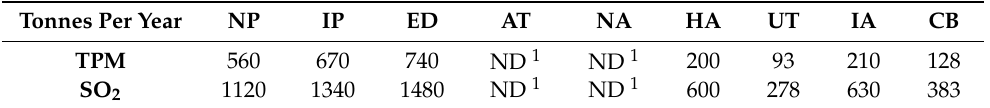
Table 3. Annual recommended limits (ARL) for TPM and SO 2 releases according to the CPMAEPPF (retrieved from